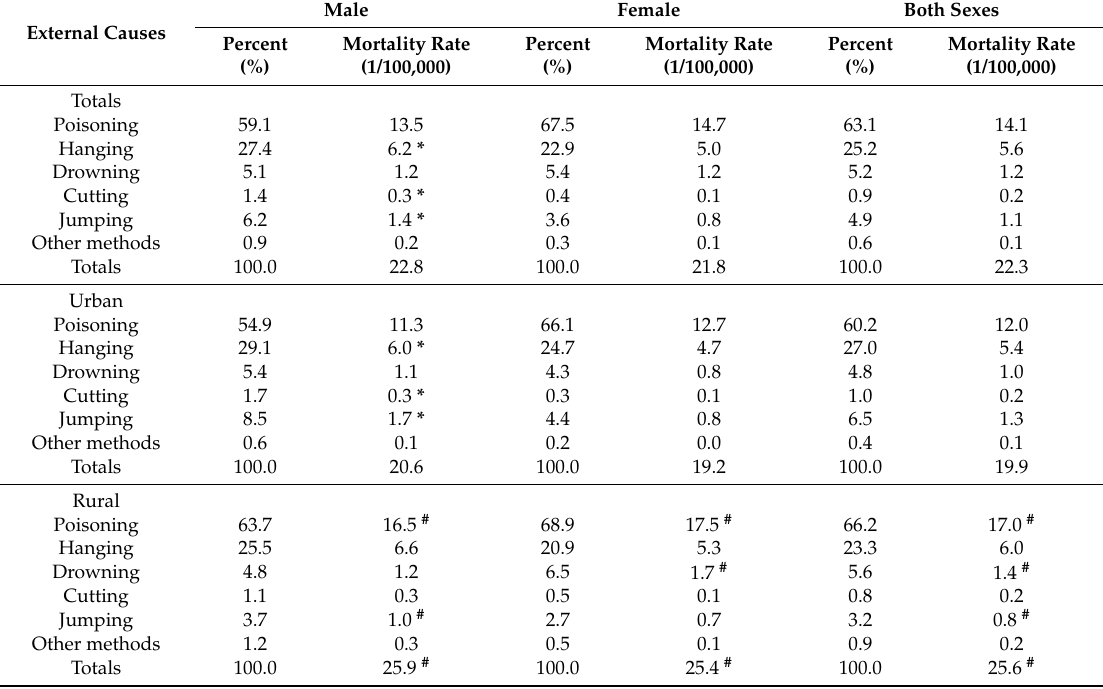
Table 4. External causes of fatal self-harm outcomes, percentage and mortality rates, by gender and